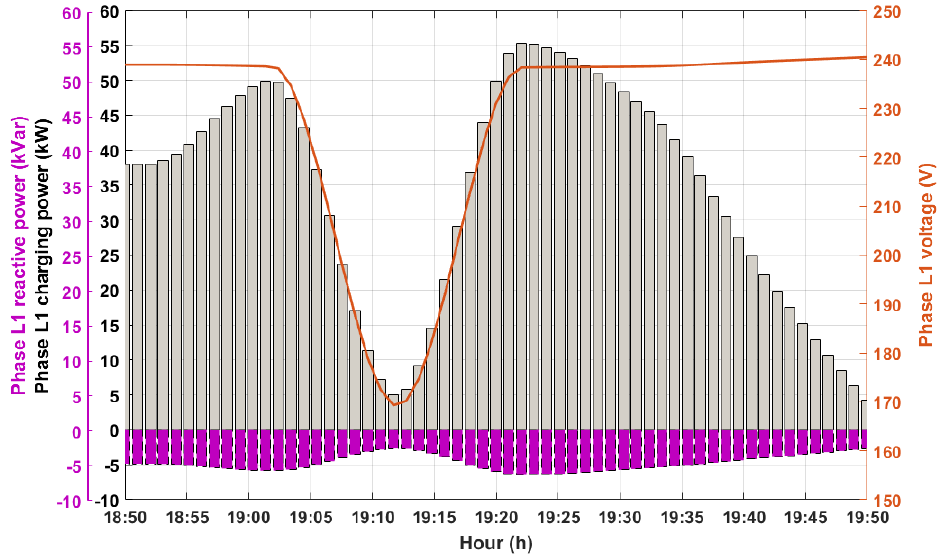
Figure 6. Voltage drop during bus charging at Sparta ń ska Street charging point [19].